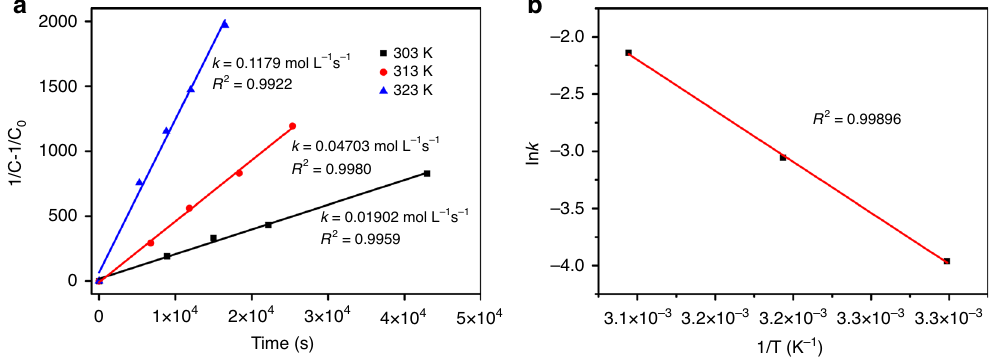
Fig. 6 Kinetics of dimerization measured in C 2 Cl 4 D 2 . a Linear regression plot showing the second-order kinetics of the dimerization of 1 . b Arrhenius plot for the dimerization of 1 . (C 0 , the initial concentration of monomer; C, temporal concentration of monomer; k , reaction rate constant; T,